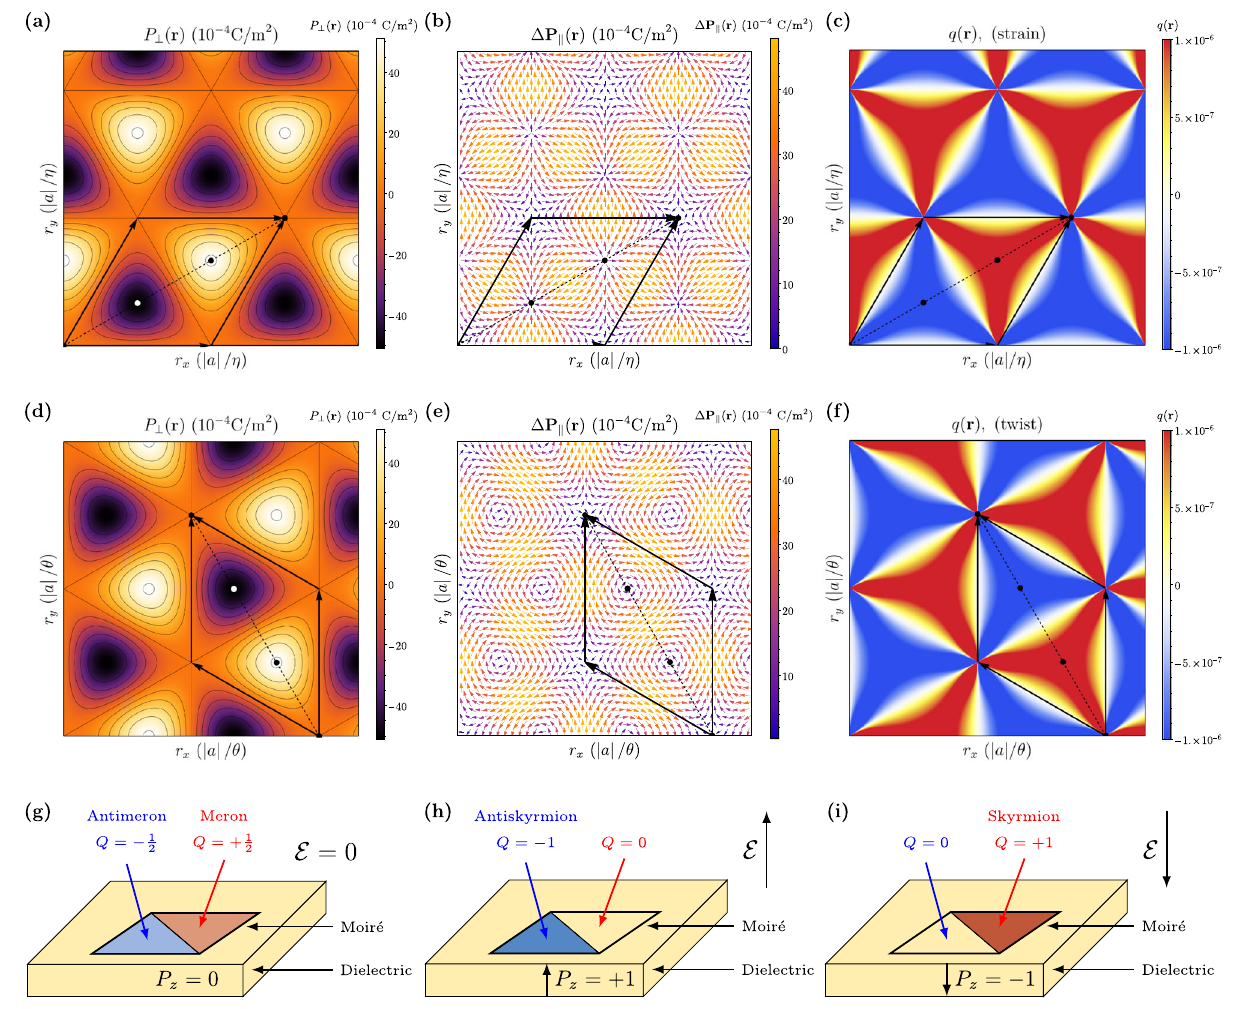
Fig. 3| PolartopologyinbilayerhBN. a Out-of-planepolarization P ⊥ ( r ), b change in in-plane polarization P ∥ ( r ) and c local topological charge q ( r ) for biaxially strained hBN. d out-of-plane polarization, e change in in-plane polarization, and f local topological charge for twisted hBN. Plots are shown in real space r =( r x , r y ), withwithlengthscalesofthebilayerlatticeconstant ∣ a ∣ dividedbystrain η andtwist angle θ for strained and twisted bilayers, respectively. The black arrows represent theMoirésuperlatticevectorsineachcase. g – i Proposalofasysteminwhichpolar topological phase transitions may be driven by an applied electric fi eld E . A single